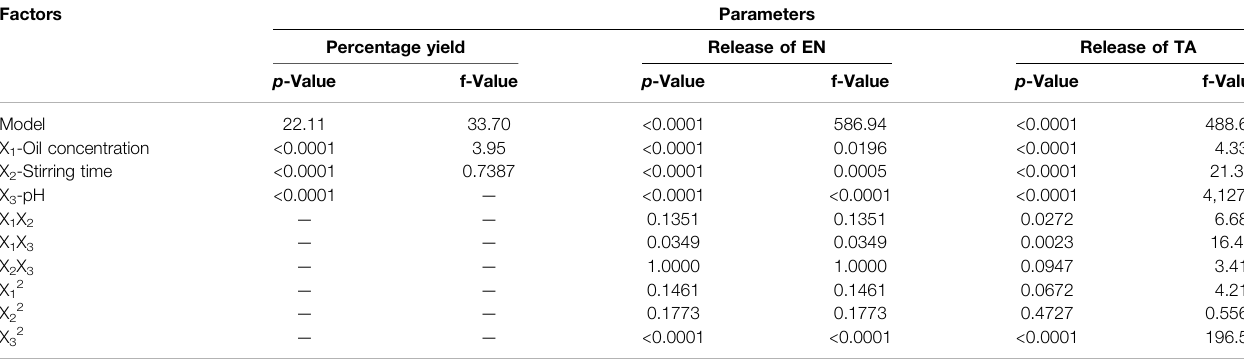
TABLE 2 | Results of ANOVA for responses Y 1 , Y 2 and Y 3 from EN-TA loaded MSNs.